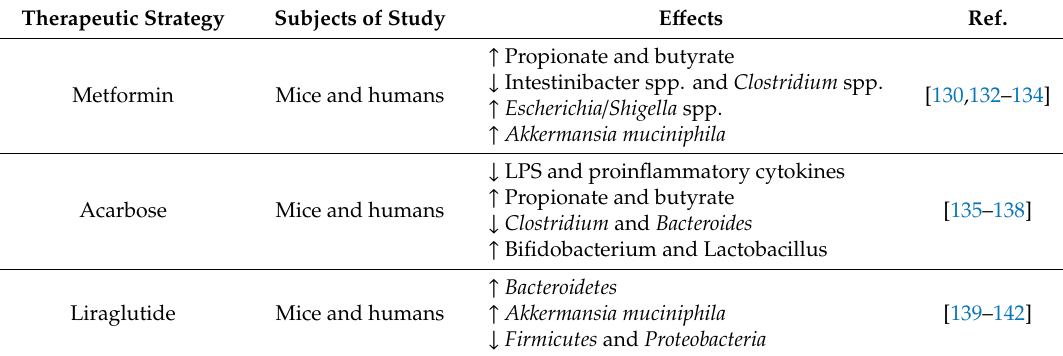
Table 2. Manipulation of gut microbiota with oral antidiabetics for diabetes treatment and prevention. Therapeutic Strategy Subjects of